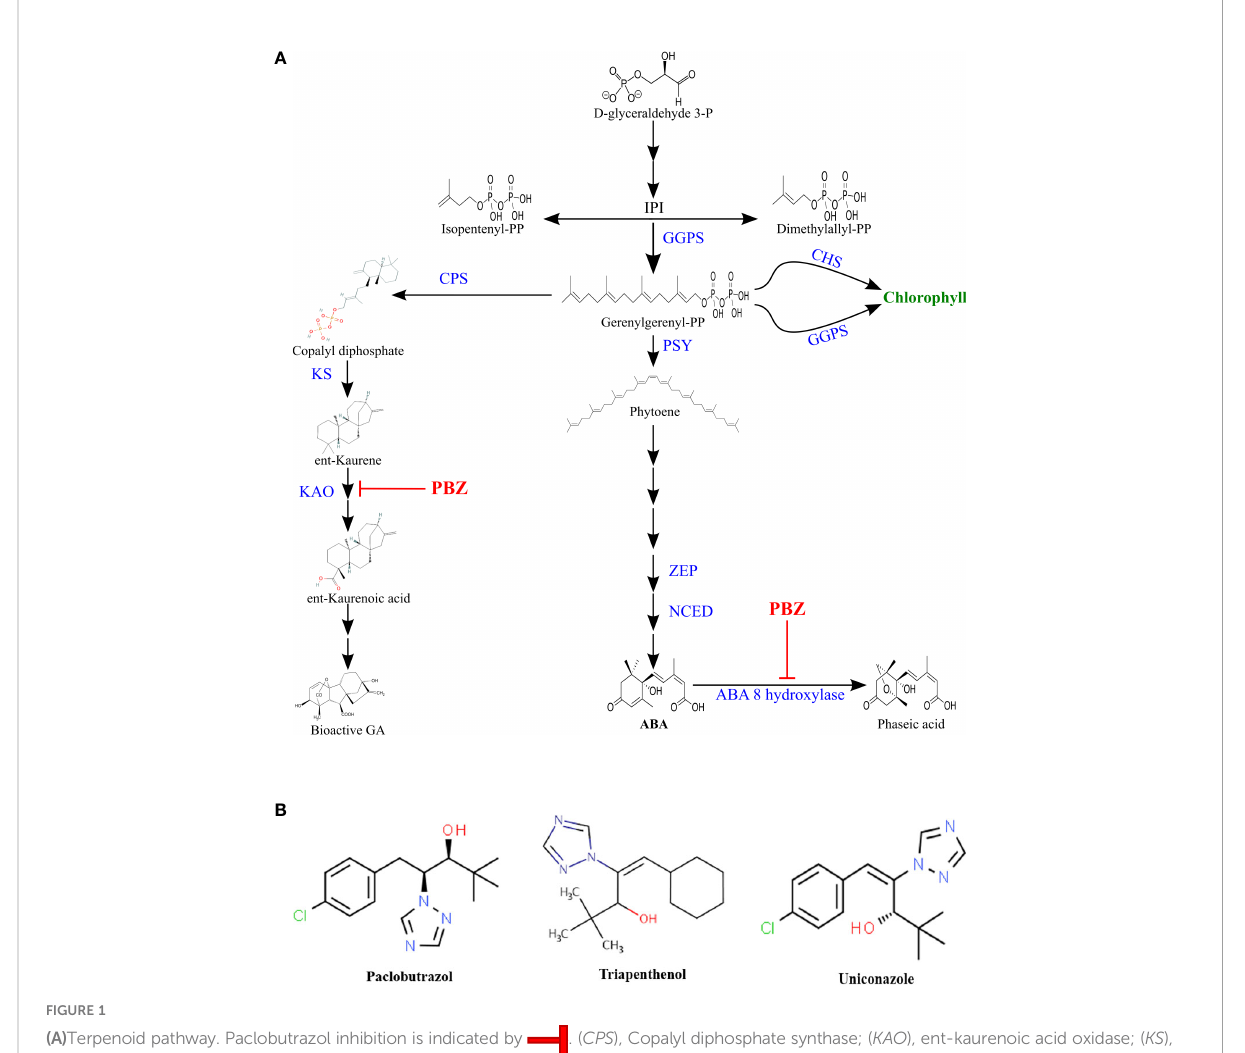
(A) Terpenoid pathway. Paclobutrazol inhibition is indicated by . ( CPS ), Copalyl diphosphate synthase; ( KAO ), ent-kaurenoic acid oxidase; ( KS ), ent-kaurene synthase; ( GGPPS ), geranylgeranyl pyrophosphate synthase; ( PSY ), phytoene synthase; ( ZEP) , zeaxanthin epoxidase; ( NCED ), 9- cis epoxycarotenoid dioxygenase; ( CHS ), chlorophyll Synthase; ( GGRS ), geranylgeranyl reductase. (B) Chemical structure of some